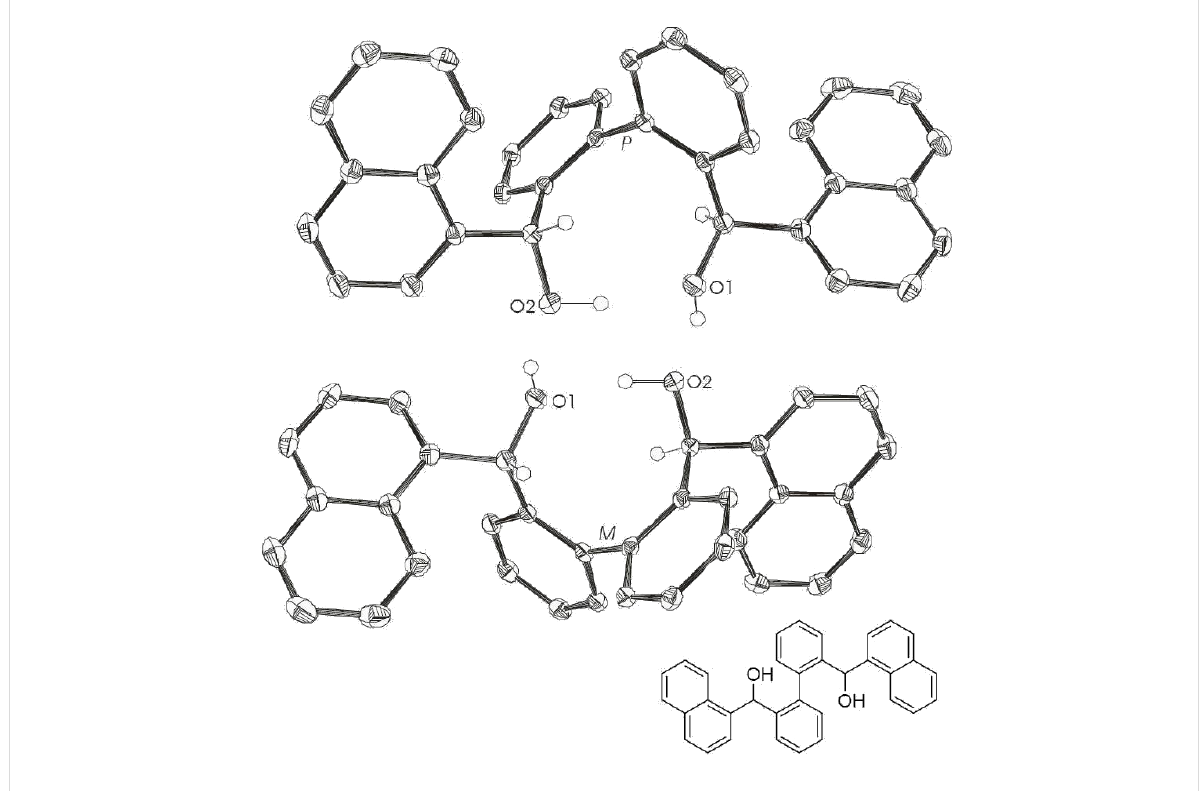
Figure 2: X-ray crystal structure of 7 . ( M ) - ( S,S ) and ( P ) - ( R,R ) pair of enantiomers; intermolecular O1–O2 distance 2.80 Å; intramolecular O1–O2 dis- tance 2.81 Å. Ellipsoids correspond to 50% probability levels. Hydrogen atoms are omitted for clarity.